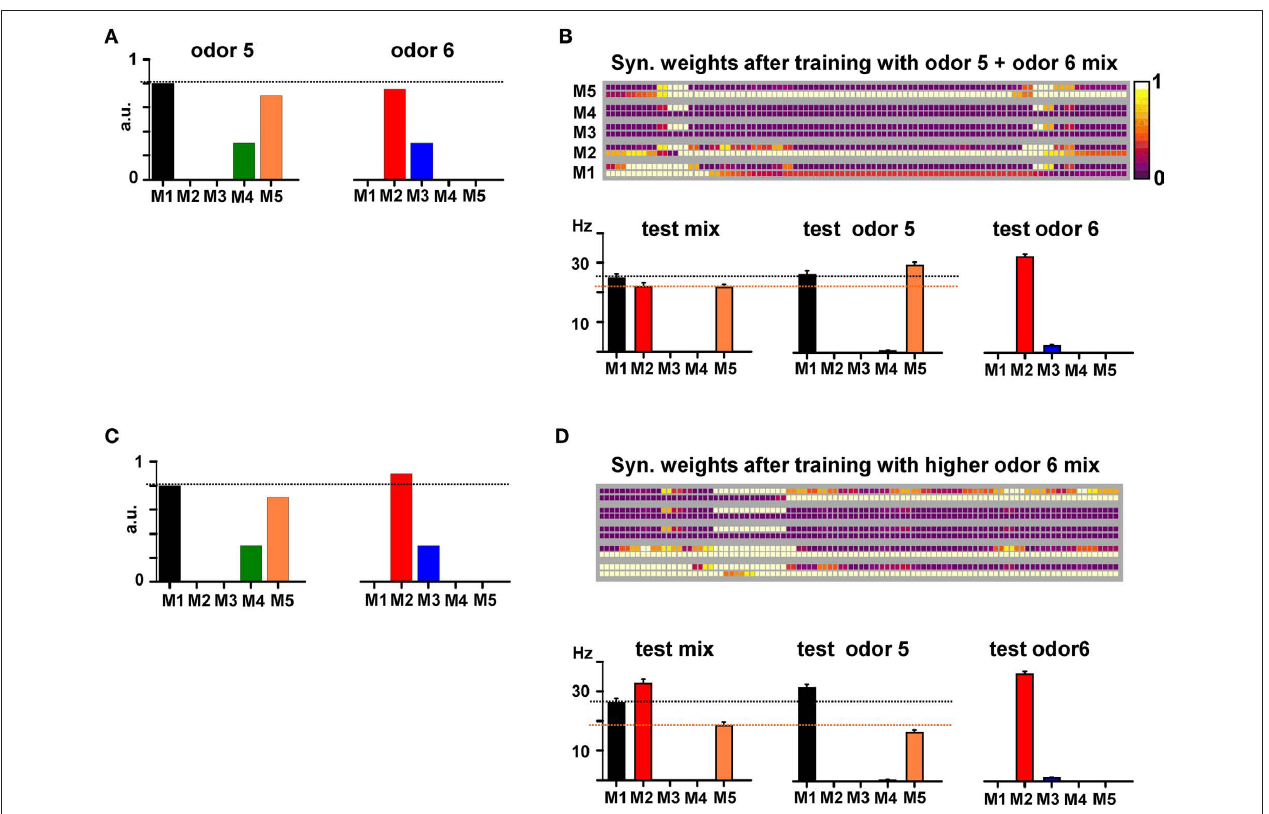
FIgure 8 | Synthetic or analytical properties of non-overlapping binary mixtures depend on cluster interactions. (A) Relative strengths of the synaptic inputs on the tufts of each mitral cell (M1–M5) to model two odors activating different mitral cells (i.e., non-overlapping glomeruli). (B) Top : Synaptic weights after training with the mixture of the two odors; bottom : average firing rate for M1–M5 during 6, 10 s, simulations testing the mixture